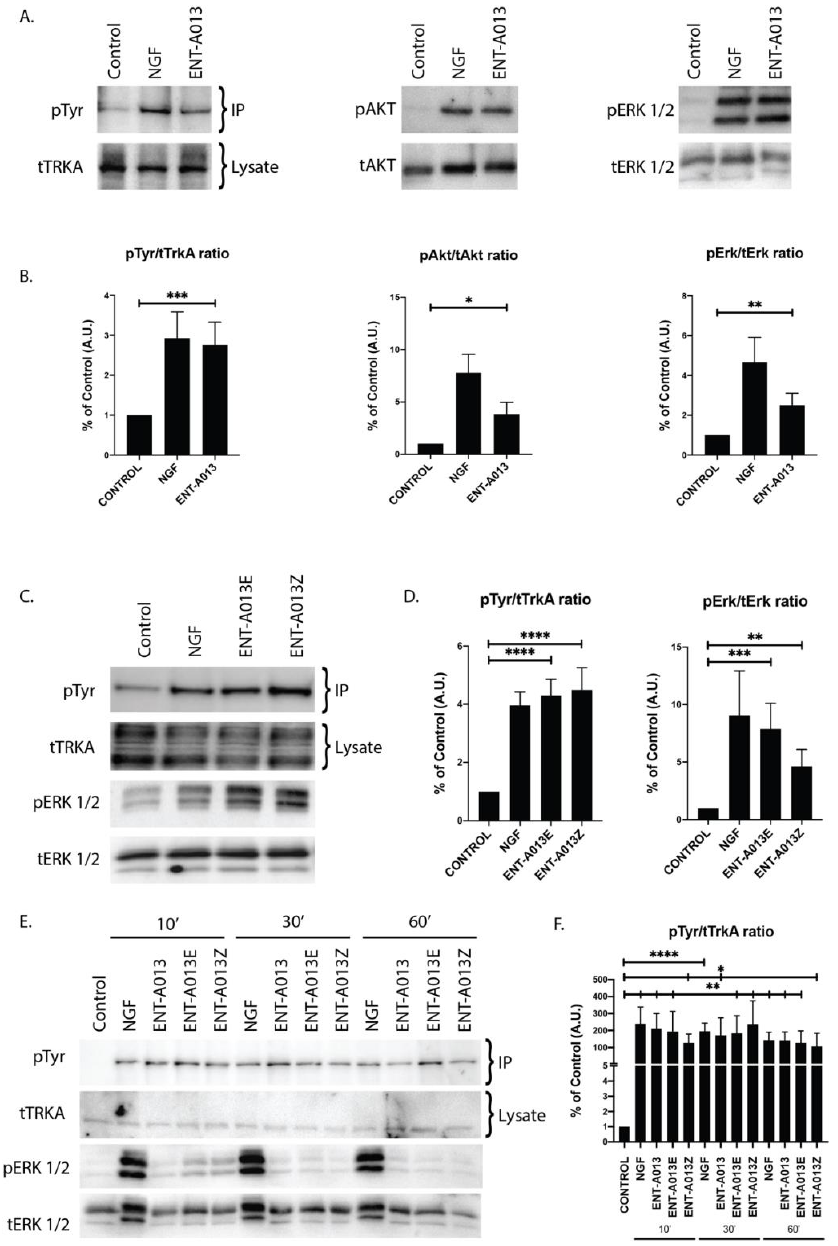
Figure 3. ENT-A013 ([E,Z (1:1) mixture] and the pure geometrical isomers ENT-A013E and ENT- A013Z activate TrkA and its downstream signaling kinases. ( A , B ) 30 (cid:48) treatment of PC12 cells with ENT-A013 or vehicle was able to induce strong phosphorylation of TrkA and its downstream sig- naling kinases Akt and Erk1/2 as shown by immunoprecipitation or whole lysate Western blots. Representative blots of 3–6 independent experiments ( A ) and quantification ( B ) are shown. Data are shown as ± SEM; Student’s t -test against control:* p<0.05; ** p < 0.01; *** p < 0.001. ( C , D ) 30 (cid:48) treatment of PC12 cells with ENT-A013E and Z or vehicle was able to induce phosphorylation of TrkA and Erk1/2 as shown by immunoprecipitation or whole lysate Western blot respectively. Representative blots of 4–6 independent experiments ( C ) and quantification ( D ) are shown. Data are shown as ± SEM; Student’s t-test against control: * ** p < 0.01; *** p < 0.001; **** p<0.0001. ( E , F ) PC12 cells treated for 10 (cid:48) , 30 (cid:48) or 60 (cid:48) with ENT-A013, ENT-A013E, ENT-A013Z or vehicle show that all compounds can induce TrkA phosphorylation, which is sustained over 60 (cid:48) after treatment. Representative blots of 3 (IP) or 2 (Erk1/2) independent experiments ( E ) and quantification for pTyr activation ( F ) are shown. Data represent ± SEM; Student’s t -test against control: * p < 0.05; ** p < 0.01; **** p <